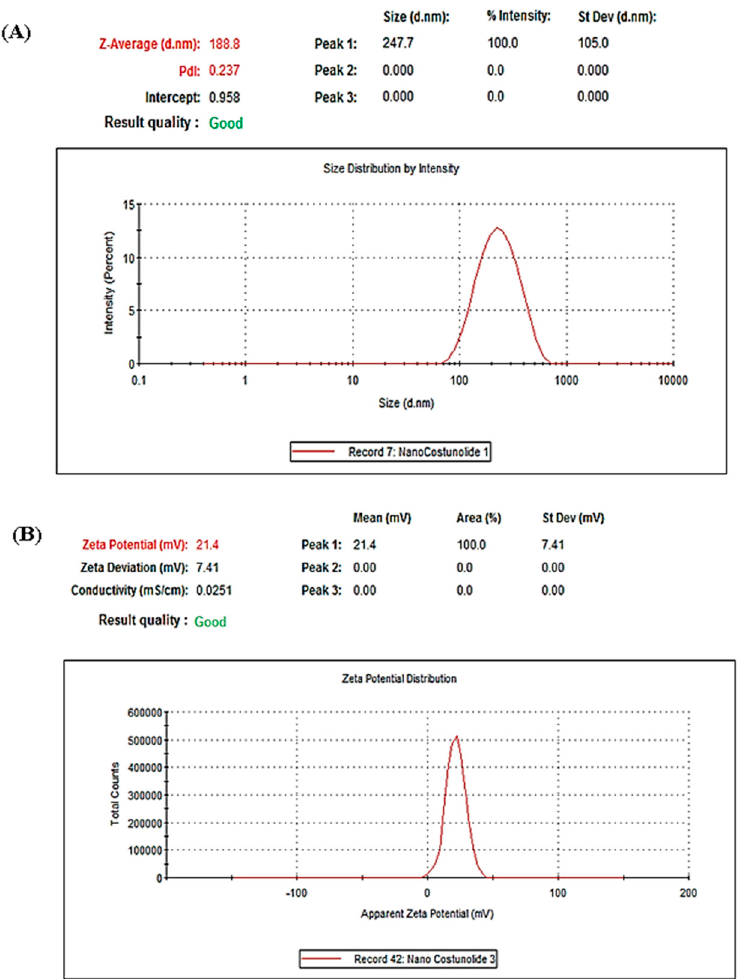
Figure 1. Particle size distribution as measured with Dynamic Light Scattering. ( A ) Z-average size = 188.8 nm. ( B ) zeta potential= 21.4 mV.